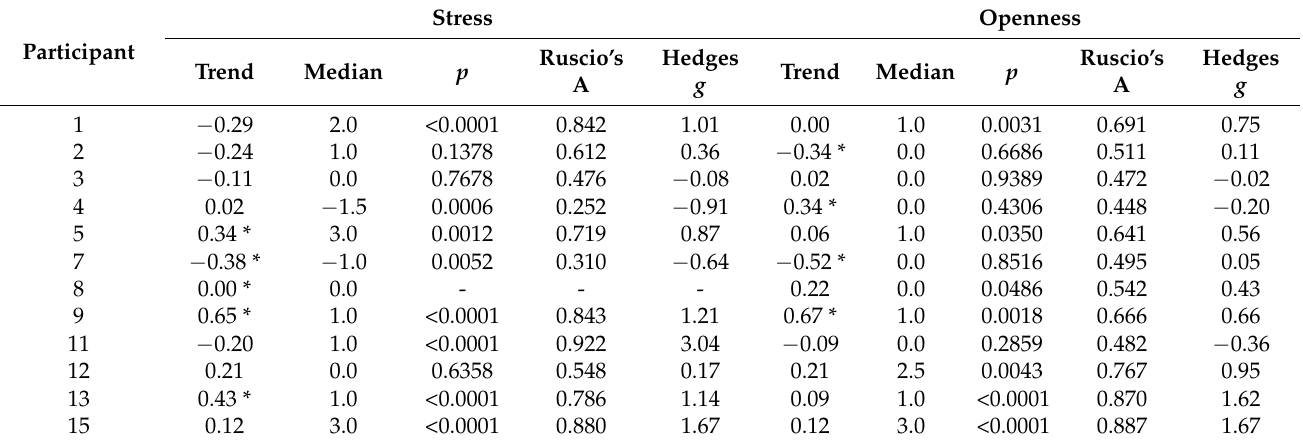
Table 11. Quantitative analyses summaries for awareness and valued